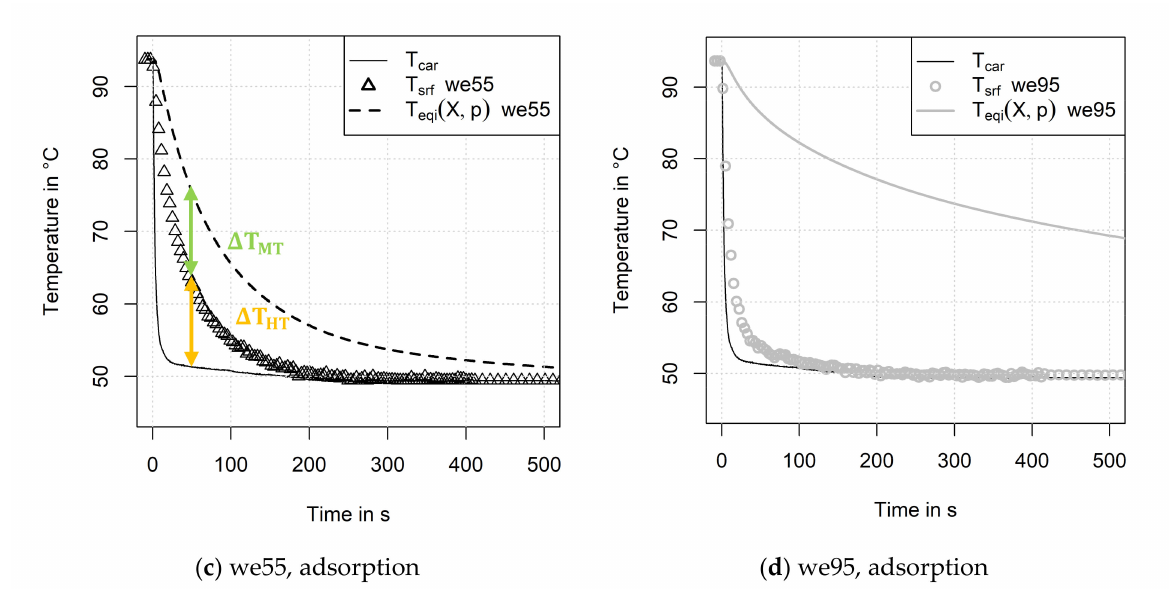
Figure 9. Evaluation of temperatures according to Figure 3b allowing to deduce the effective driving temperature differences for heat and mass transfer as indicated in the lower left plot for samples we55 and we95.